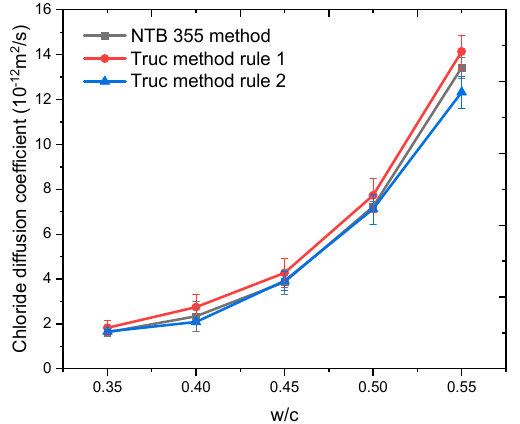
Table 5. The calculated effective chloride diffusion coefficient of all mixtures.